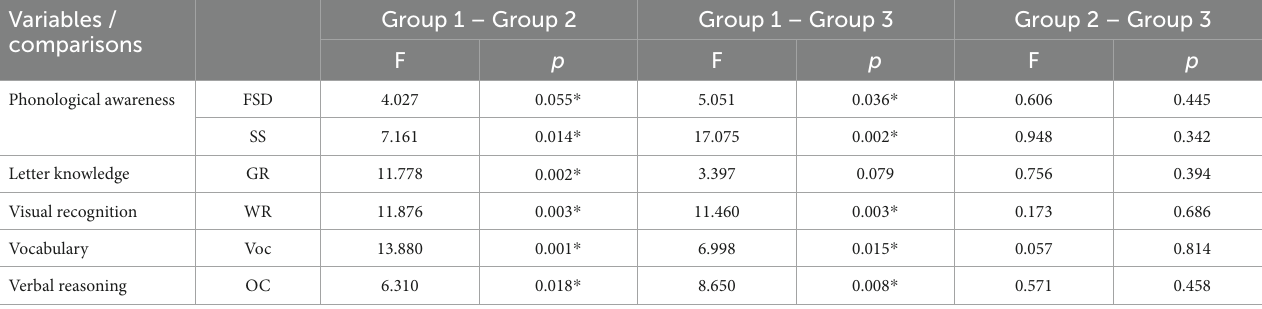
TABLE 5 Post-hoc analyses for the variables with significant differences by age group.